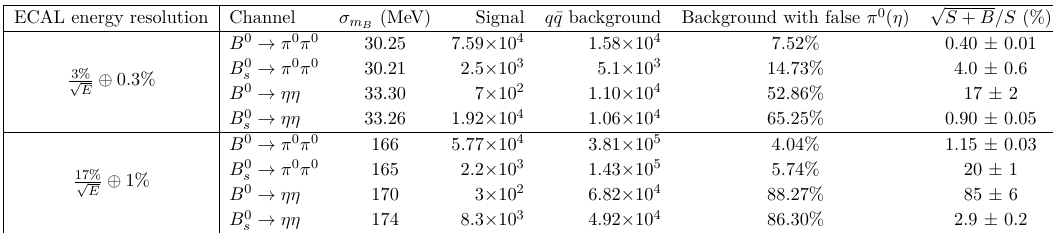
→ π 0 π 0 and B 0 → ηη at different ECAL energy ( s ) ( s )